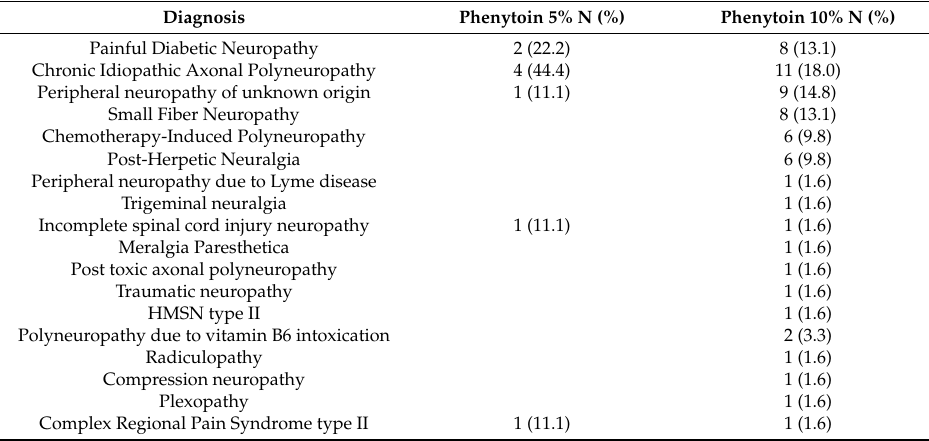
Table 1. Neuropathy diagnoses and summary of treatment regimens.